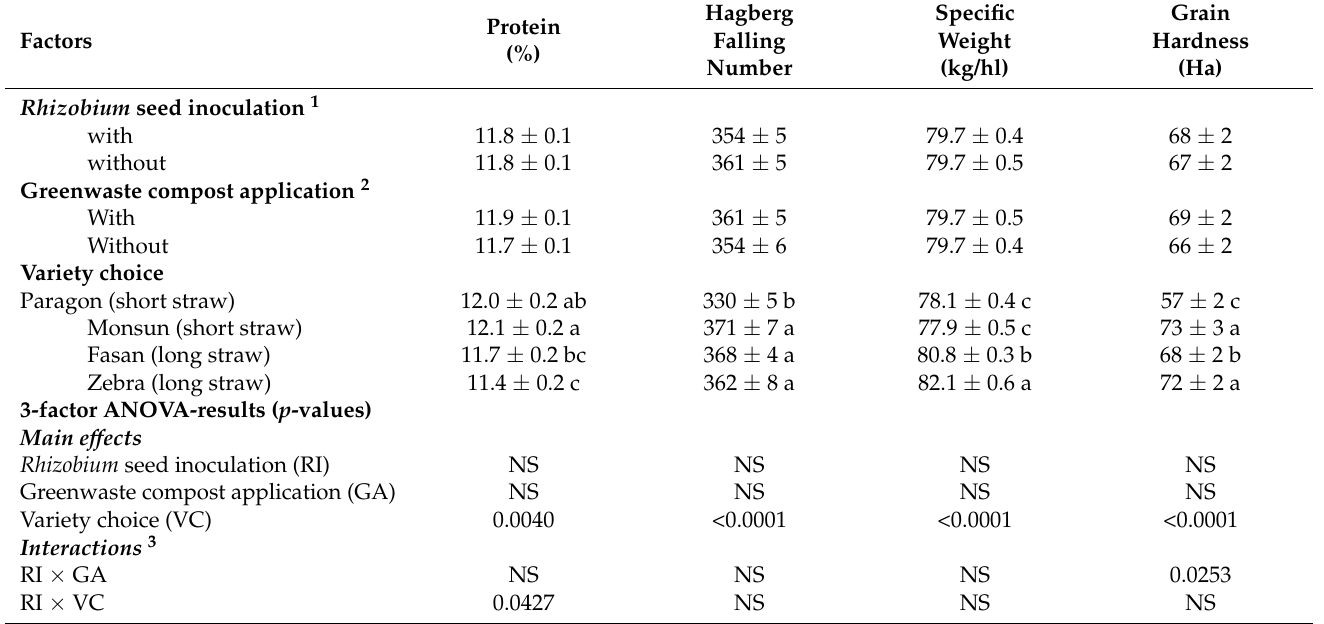
Table 10. Effect of clover ley management ( Rhizobium inoculation of clover seed and greenwaste compost applications) on grain quality performance parameters (protein concentration, Hagberg falling number, specific weight and grain hardness) in contrasting spring wheat varieties